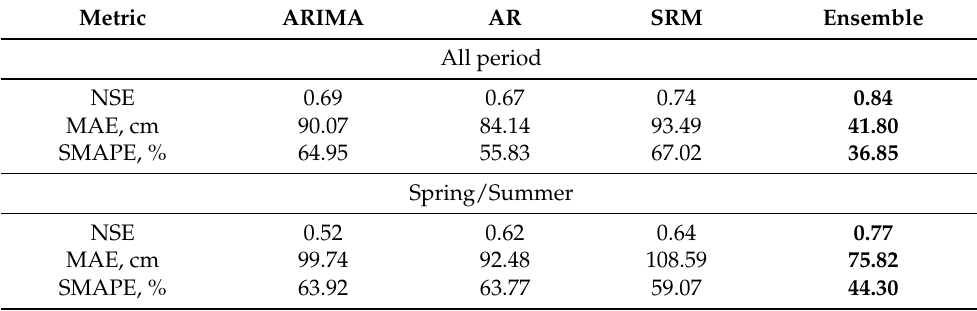
Table 8. Summarized table for models for all period and spring/summer period